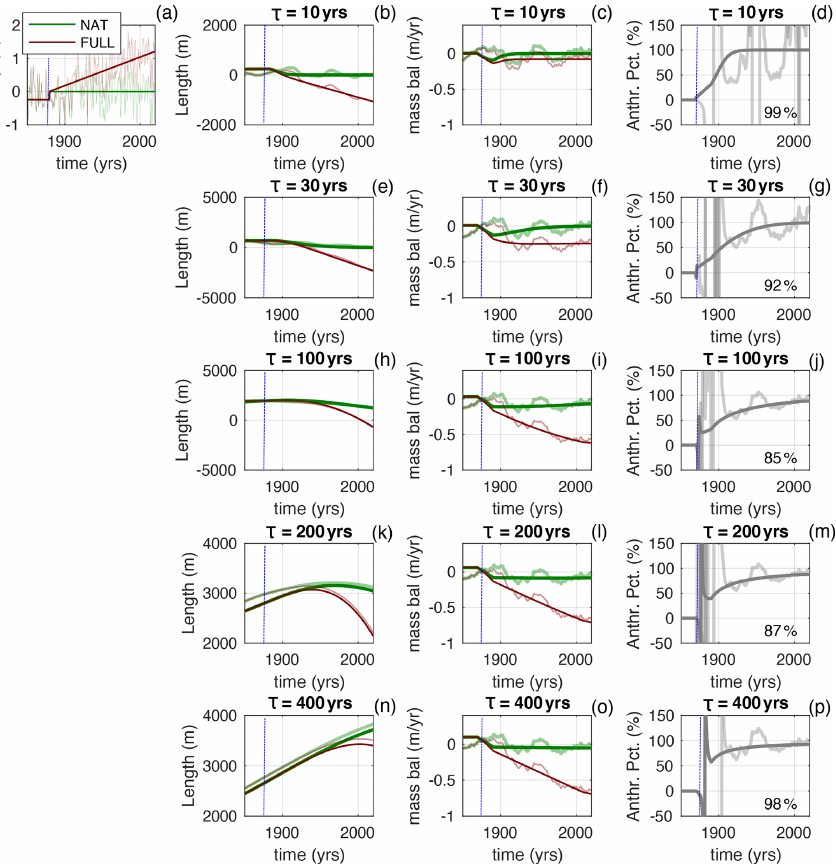
Figure 5. Same as Fig. 4 but zoomed into the period 1850 to 2020. The percentages inserted into the right-hand columns give the anthro- pogenic cumulative mass loss relative to the total cumulative mass loss between 1880 and 2020. Note these cumulative percentages will not, in general, be equal to the time average of F anth